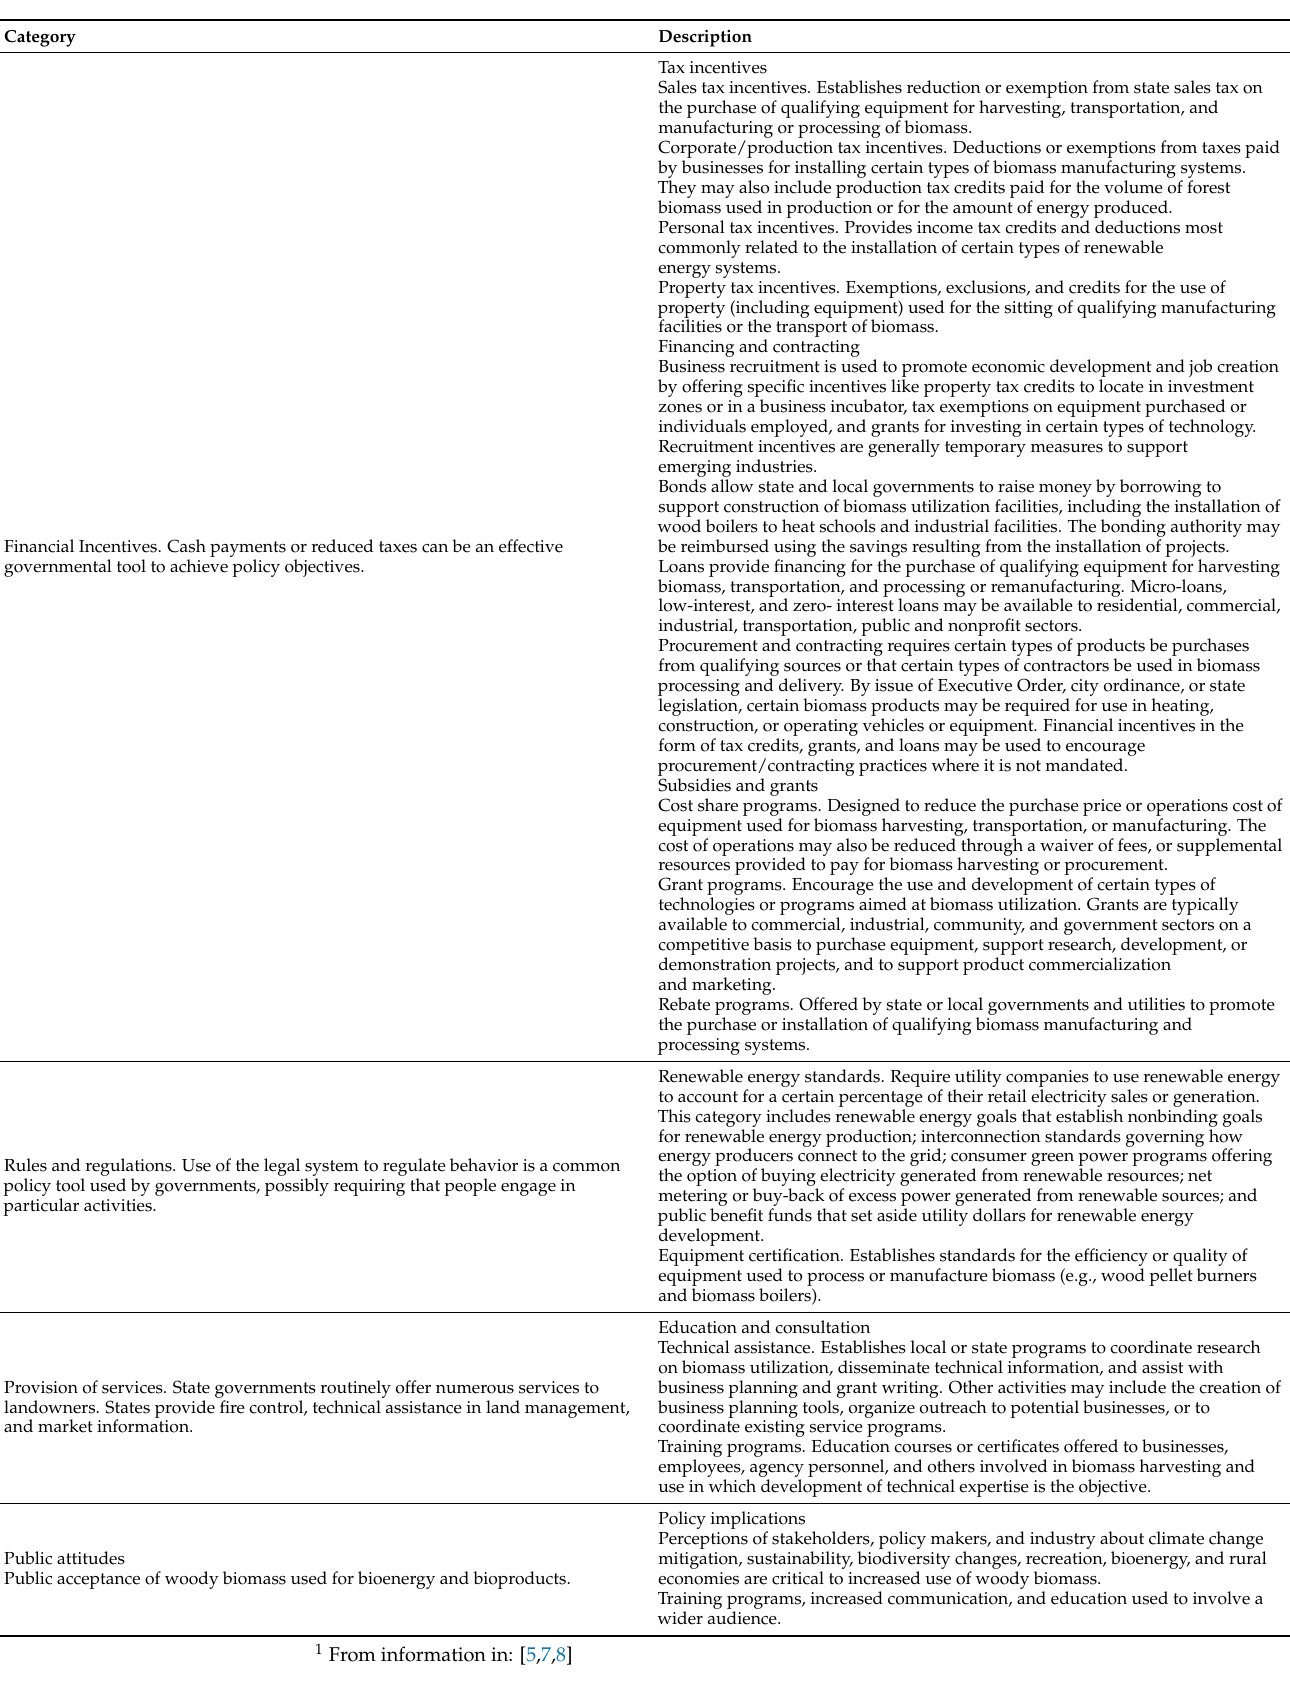
Table 1. Policy instruments to promote the use of woody biomass in the U.S. 1